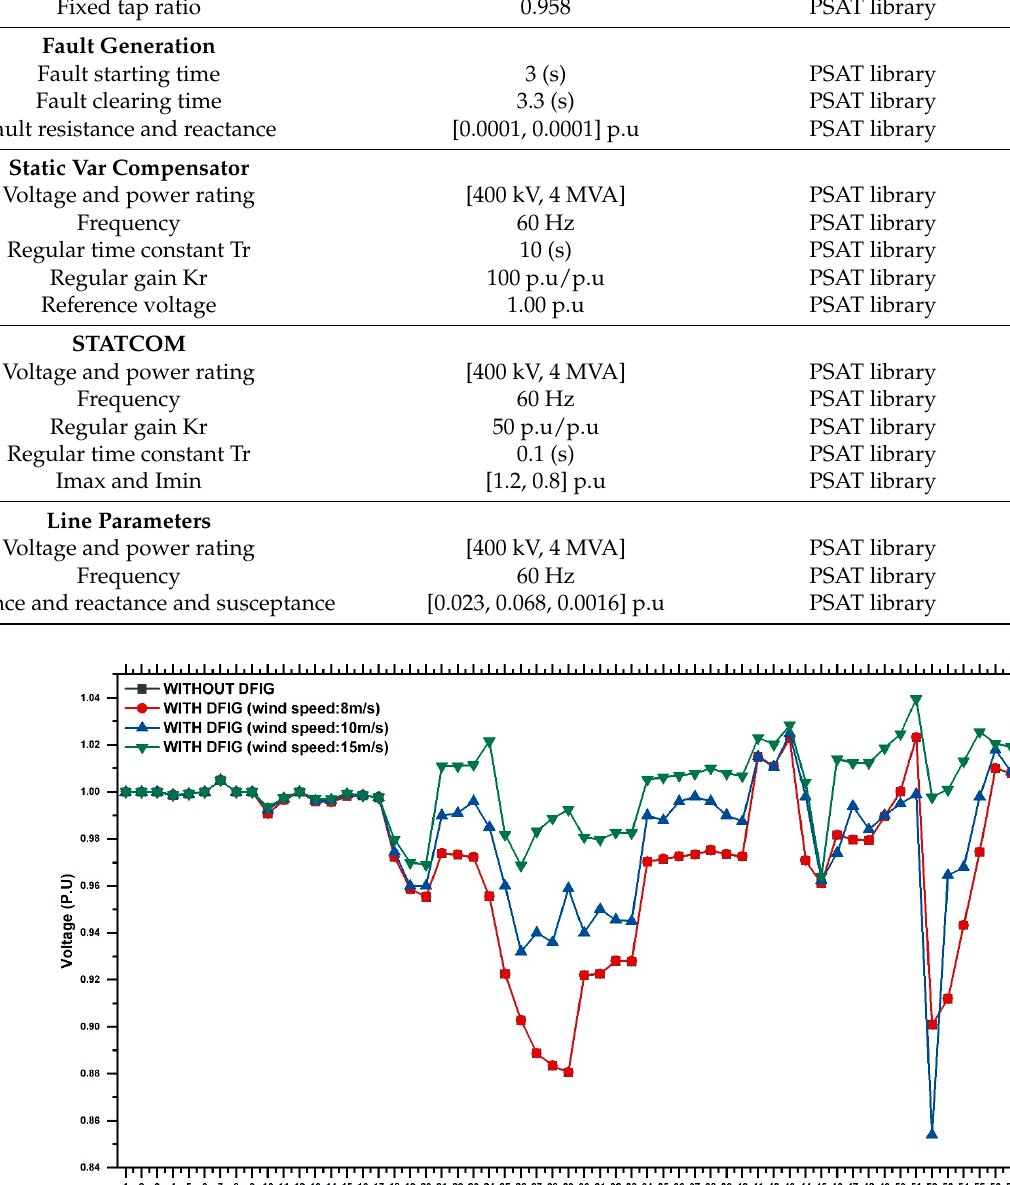
Figure A2. Comparison of SCIG output voltage with different wind speeds.